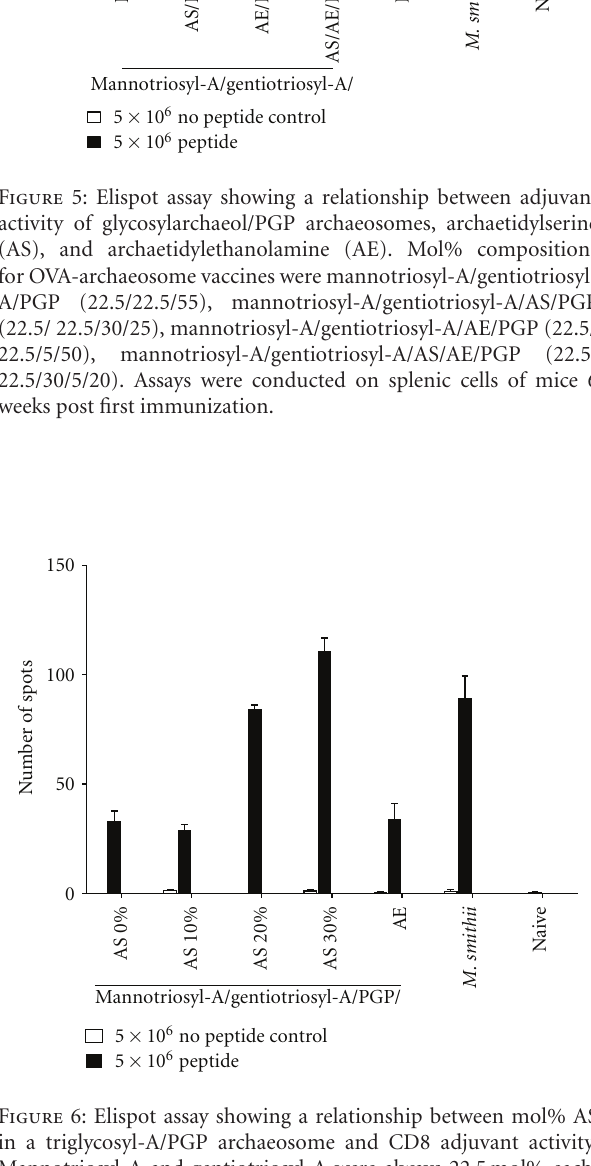
Figure 6: Elispot assay showing a relationship between mol% AS in a triglycosyl-A/PGP archaeosome and CD8 adjuvant activity. Mannotriosyl-A and gentiotriosyl-A were always 22.5 mol% each. AS was varied as shown at 0, 10, 20, and 30mol%, with PGP making the remainder of each composition. For comparison, archaeosomes containing 5mol% AE and M. smithii total polar lipid archaeosomes are included.